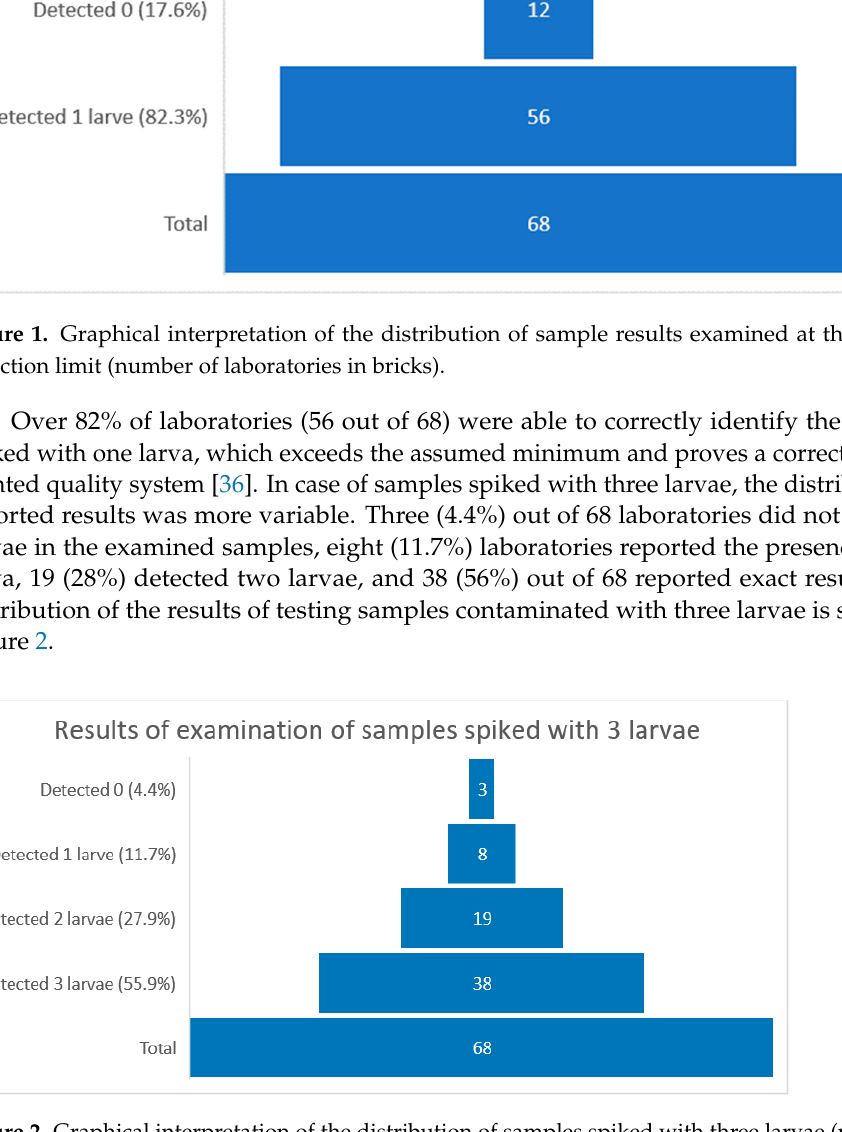
Figure 3. Graphical interpretation of the distribution of samples results spiked with five larvae (number of laboratories in bricks). Within this group of samples, three laboratories (4.4%) were not able to find a single larva. The detection of one larva was reported once (1.5%), while the detection of two, three, and four Trichinella spp. was reported by 9 (13.2%), 17 (25%), and 13 (19.1%) participants, respectively. Correct results were reported for the five detected larvae by 25 (36.8%). 3.3. Evaluation of the Reported Results Evaluation of the reported results was qualitatively and quantitatively performed. Since the suitability of meat for consumption is determined by finding one larva, the method of PT testing is qualitatively assessed. Detailed qualitative results of laboratory evaluation are presented in Table 3.